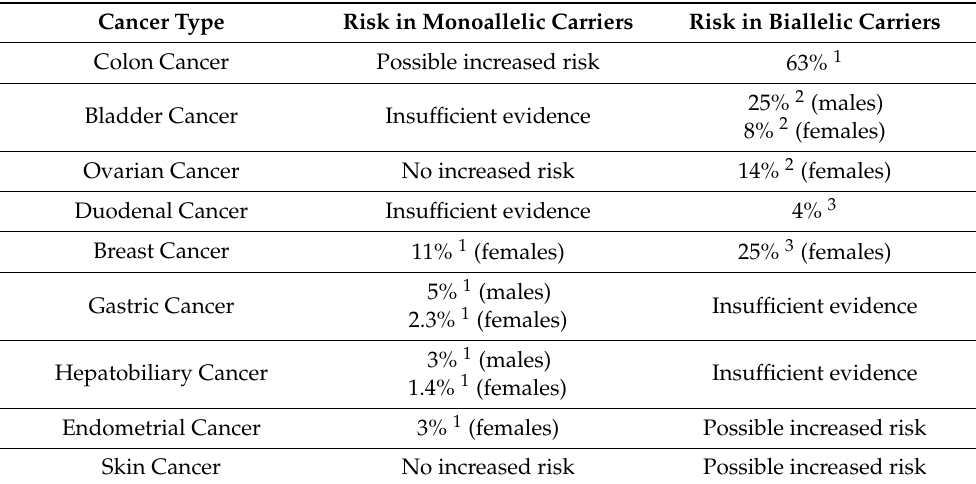
Table 1. Risk of cancer phenotypes for monoallelic and biallelic MUTYH pathogenic mutation